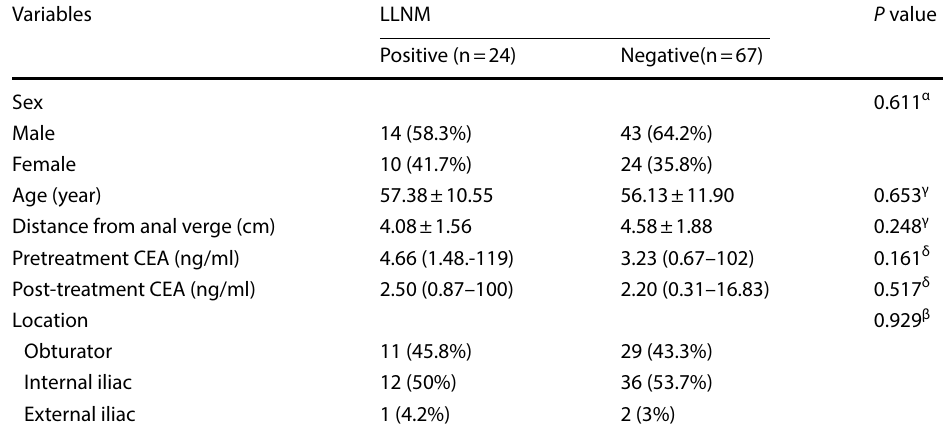
Table 1 The clinical characteristics of the study patients grouped by